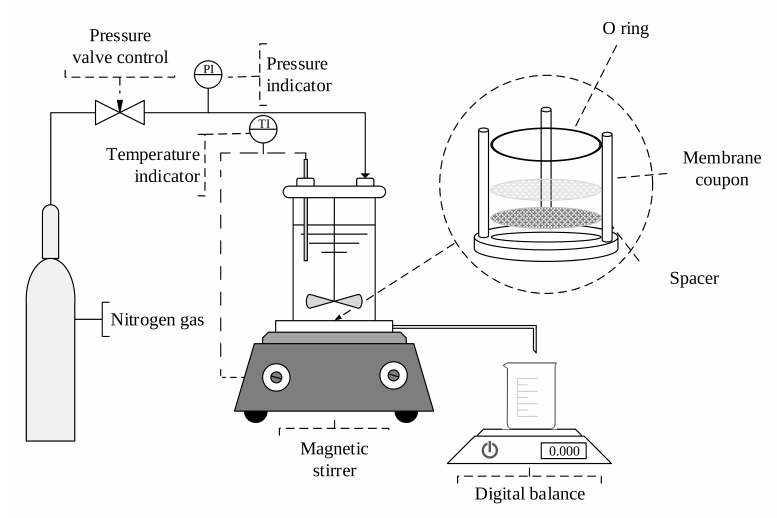
Figure 2. Schematic configuration of the dead-end filtration